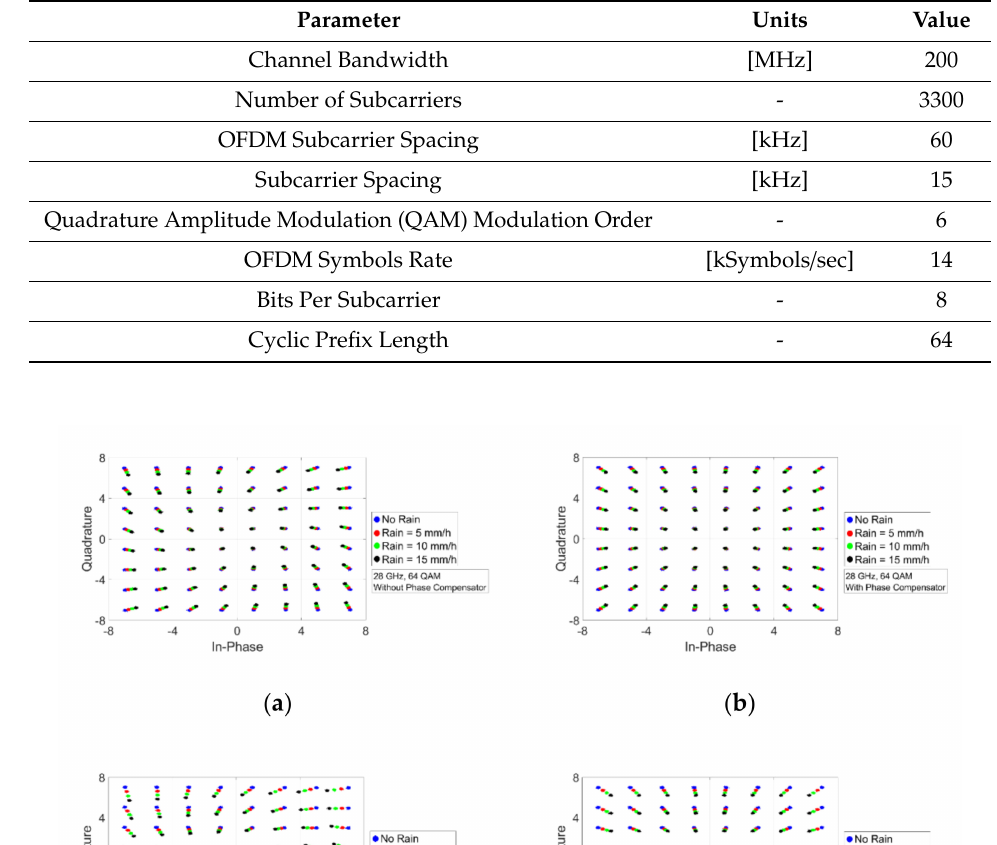
Table 3. OFDM parameters for the simulation.